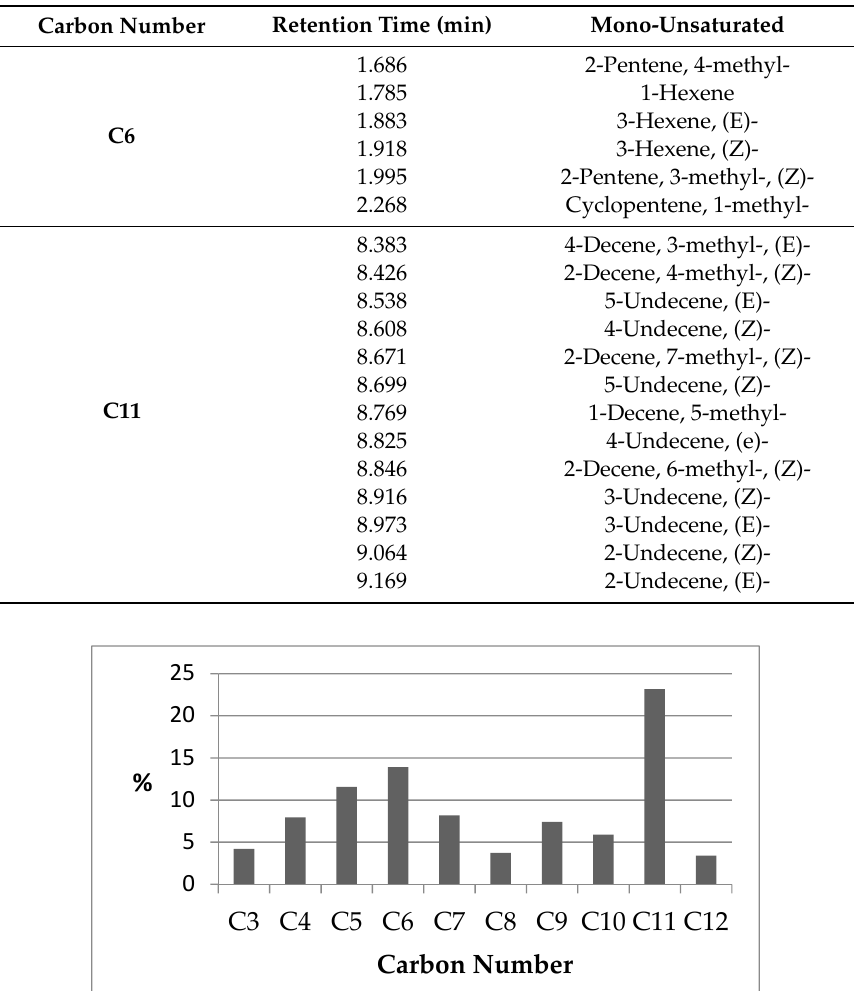
Table 2. C 6 and C 11 mono-unsaturated main products observed during dodecanoic acid pyrolysis at 650 ◦ C using Al-MCM-41 catalyst.